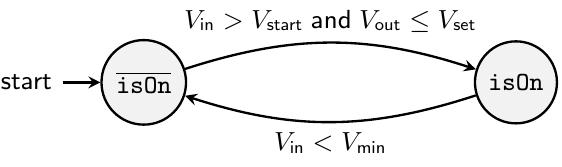
Figure 7. State diagram for isOn to model the start-up and